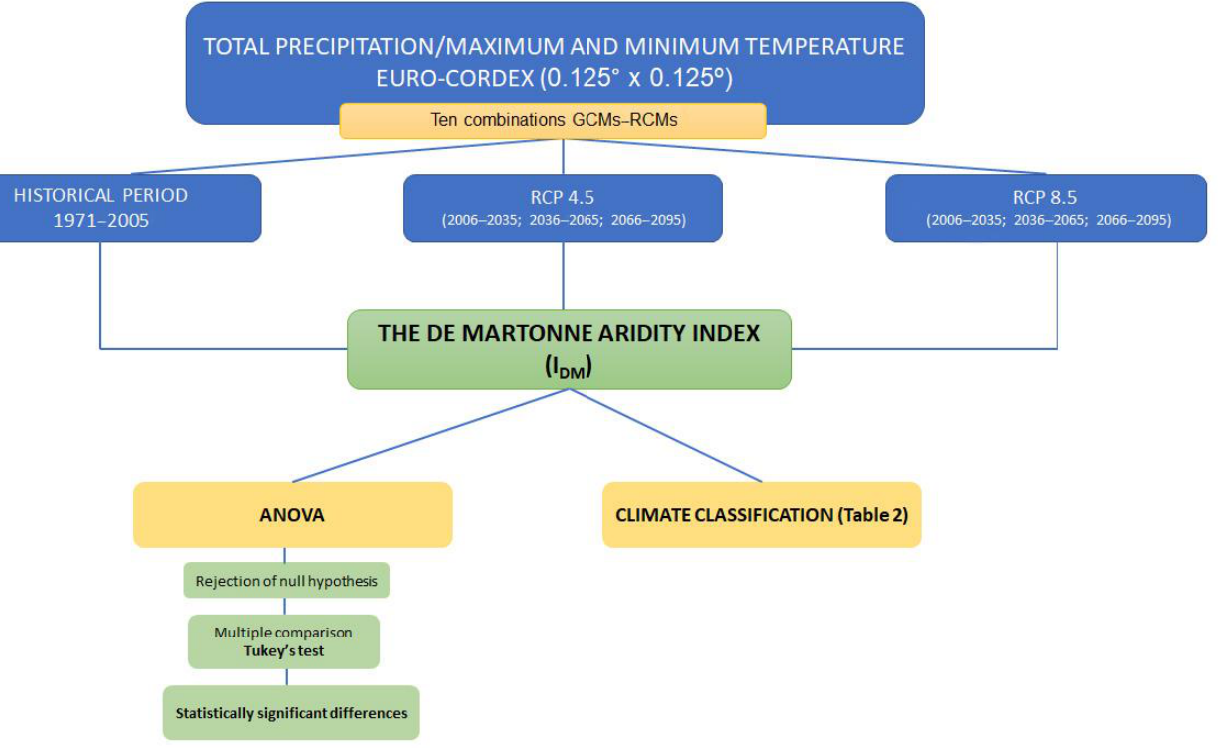
Figure 2. Overall methodological framework of this study.